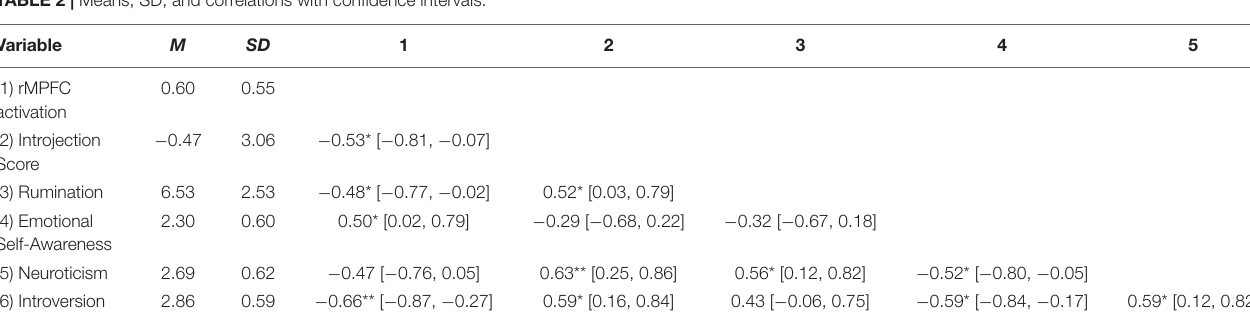
TABLE 2 | Means, SD, and correlations with confidence